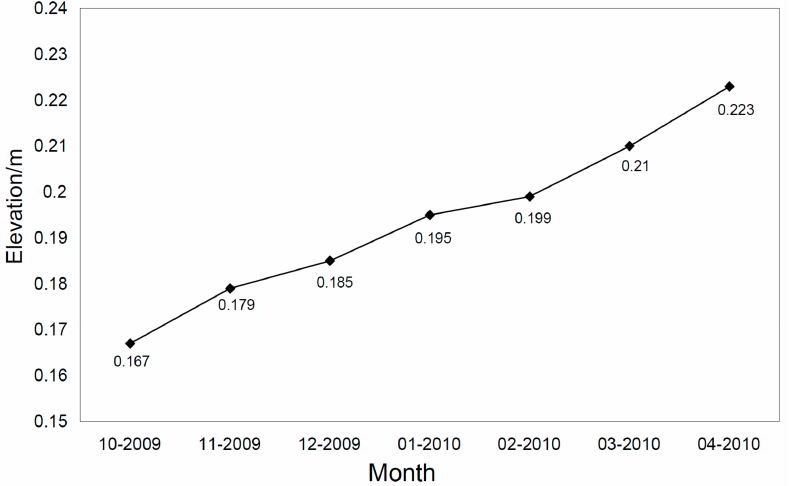
Figure 7. Mean sea ice freeboard variations in the Arctic Ocean for the 2009/2010 Arctic sea ice growth season from October to